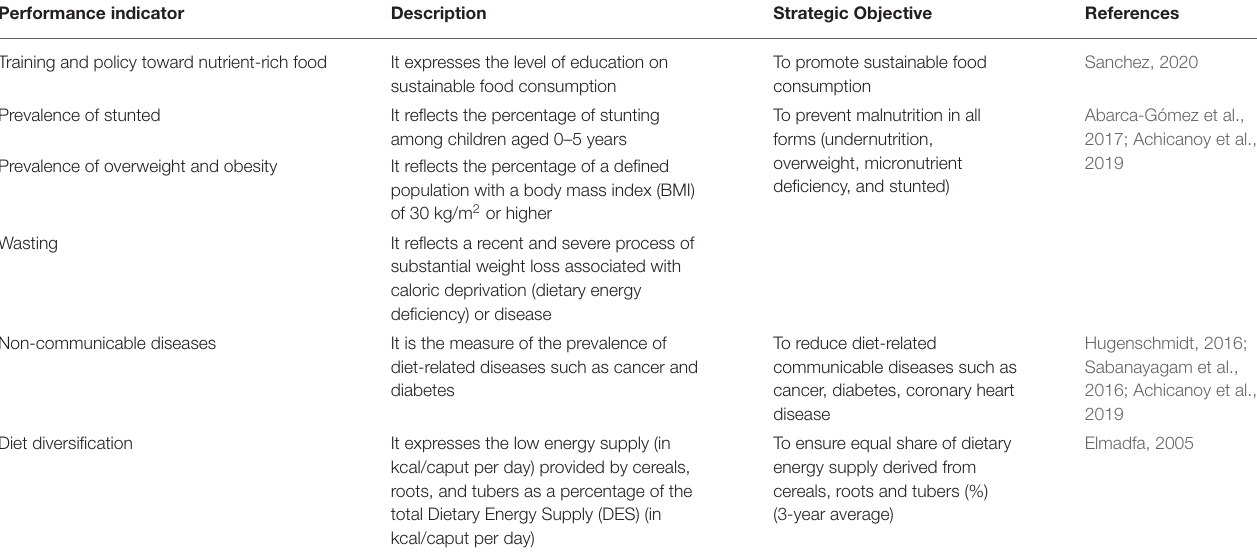
TABLE 3 | Indicators to measure the support to mitigate